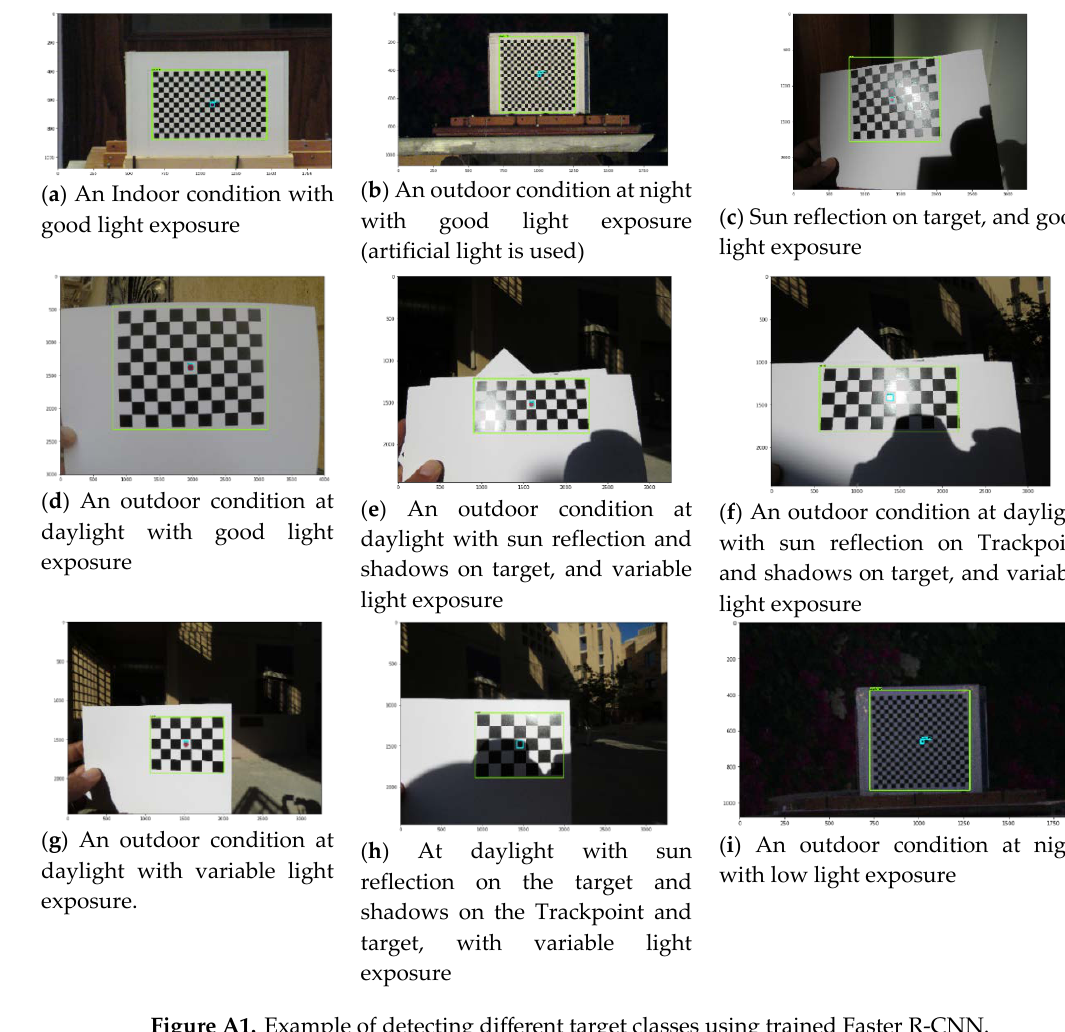
Figure A1. Example of detecting different target classes using trained Faster R-CNN. ( a ) An Indoor condition with good light exposure. ( b ) An outdoor condition at night with good light exposure (artificial light is used). ( c ) Sun reflection on target, and good light exposure. ( d ) An outdoor condition at daylight with good light exposure. ( e ) An outdoor condition at daylight with sun reflection and shadows on target, and variable light exposure. ( f ) An outdoor condition at daylight with sun reflection on Trackpoint and shadows on target, and variable light exposure. ( g ) An outdoor condition at daylight with variable light exposure. ( h ) At daylight with sun reflection on the target and shadows on the Trackpoint and target, with variable light exposure. ( i ) An outdoor condition at night with low light exposure.